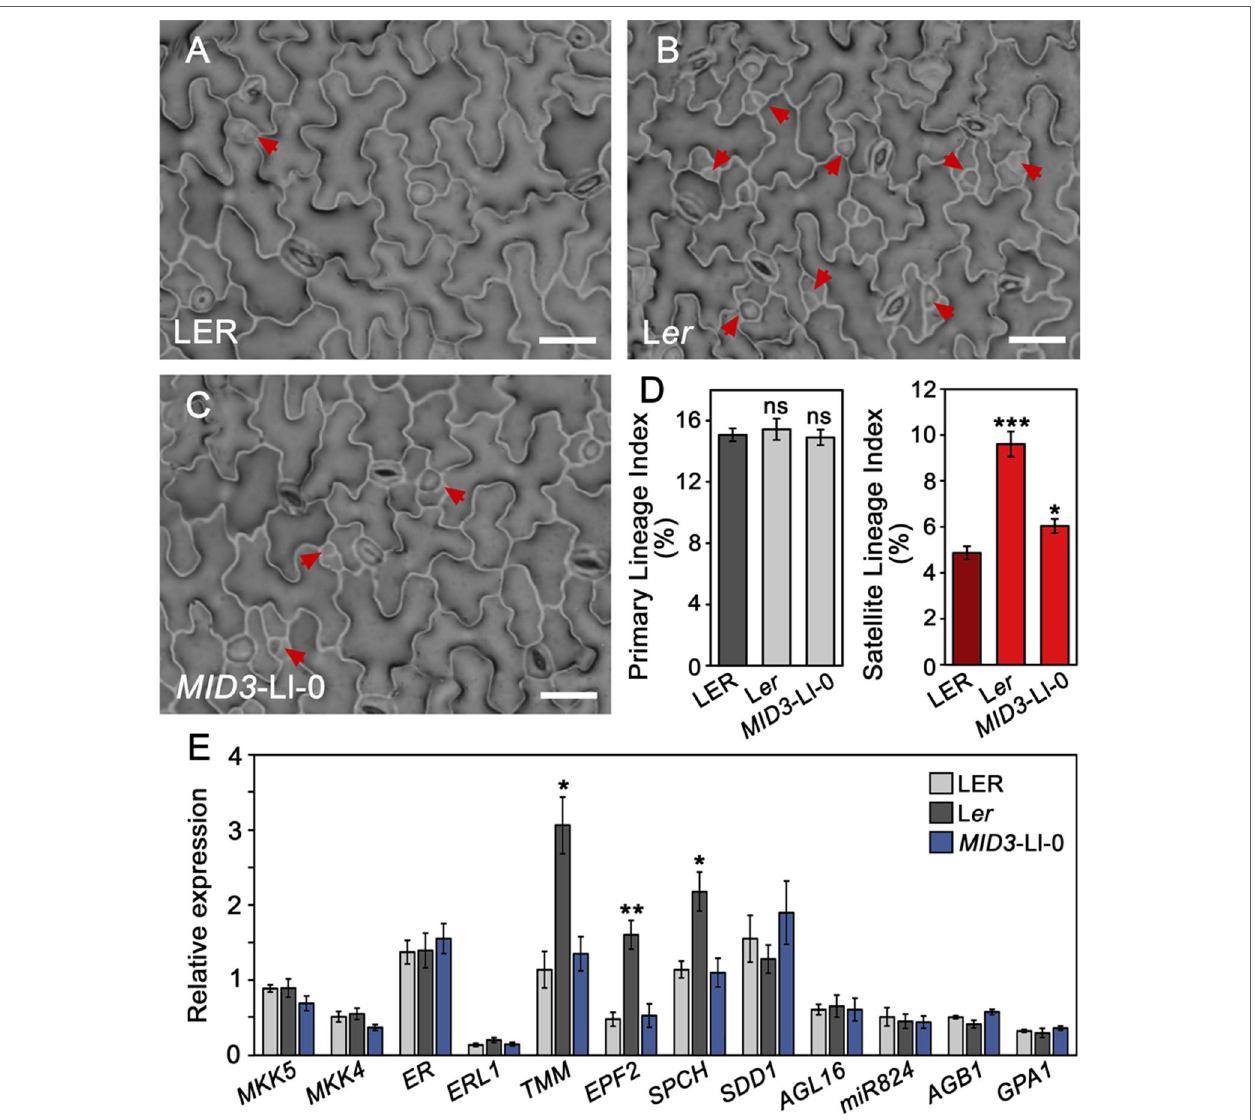
FIGURe 7 | Differential regulation of stomatal processes and gene expression by MID3 and ER . (A – D) Indexes of primary and satellite stomatal lineages were scored in the adaxial cotyledon epidermis of 3 dag seedlings for the indicated genotypes. (A – C) show representative epidermis from the plants scored; red arrows indicate satellite lineages. (D) Mean ± SD of primary (gray) and satellite (red) lineage indexes obtained from 10 to 15 plants. Asterisks indicated significant differences (*** P ≤ 0.001; * P ≤ 0.05; Student's t -test) with respect to L ER . ns, not significant differences. (e) Relative gene expression determined by qPCR for the indicated genes in 3 dag seedlings of L ER , L er , and MID3 -Ll-0 lines. Bars show the mean ± SE of three biological replicates. Asterisks indicated significant differences (** P ≤ 0.01; * P ≤ 0.05; Student's t -test) with respect to L ER